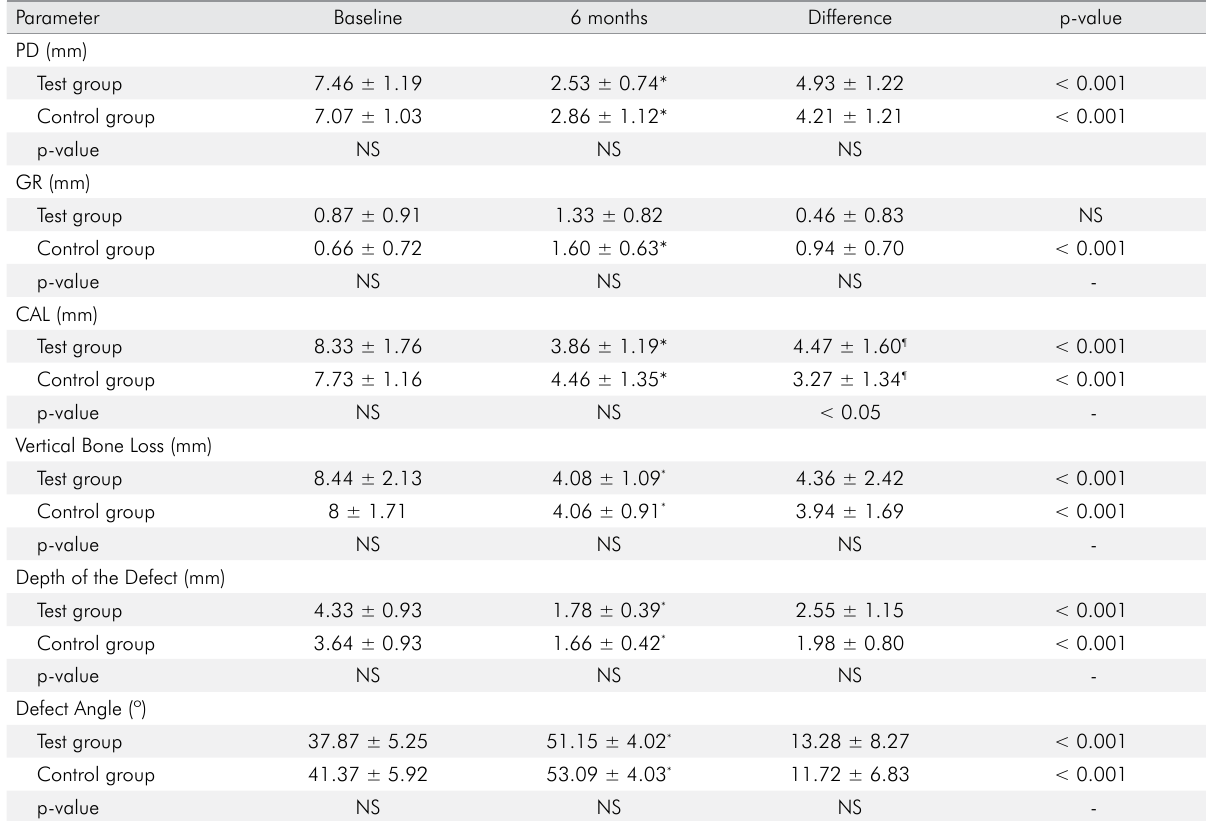
Table 4. Mean and standard deviation of clinical and radiographical measurements in both groups.